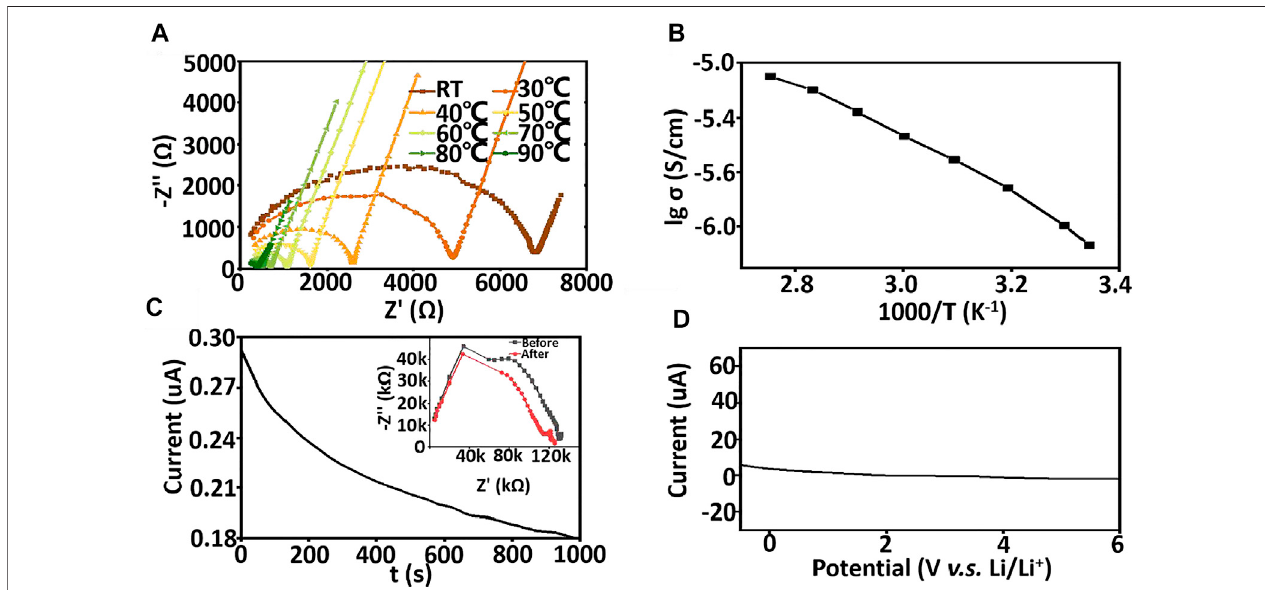
FIGURE 6 | (A) the A.C. impendence of asymmetric organic-inorganic composite solid-state electrolyte at different temperature (B) Arrhenius plots of asymmetric organic-inorganic composite solid-state electrolyte ranging room temperature to 90 ° C, (C) DC polarization curve for Li/ asymmetric organic-inorganic composite solid- state electrolyte/Li under a polarization voltage of 0.1 V. The insets show the EIS before and after the polarization. (D) LSV curve of asymmetric organic-inorganic composite solid-state electrolyte.